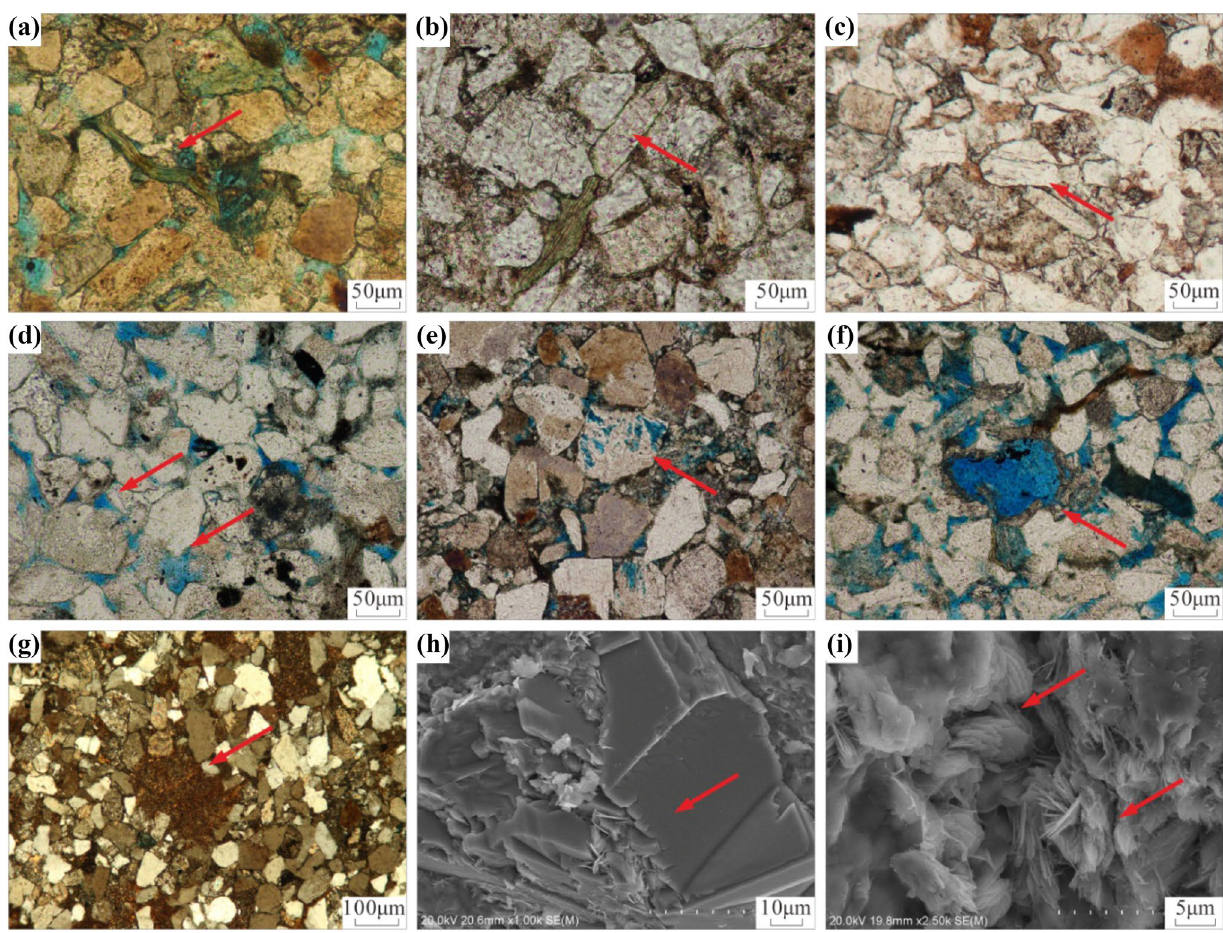
Fig. 8 Diagenetic characteristics of the Shahejie Formation reservoir in the Dawangzhuang area, Raoyang sag ( a : Well L18-24, 2694.74 m, plastic particles, bending deformation, casting sheet; b Well L494, 3772.86 m, with sandstone particles in line-to-line contact locally and thin cast body; c Well L70-114, 3755.86 m, rigid particles are bro- ken, and the cast body is thin; d Well L93, 3534.88 m, intergranu- lar corrosion, cast thin section; e Well L17-50, 3091.55 m, feldspar Fig. 9 Cross plot of pore reduc- tion rate ( a ) and distribution map of rock composition con- tent ( b ) in the Dawangzhuang area of Raoyang